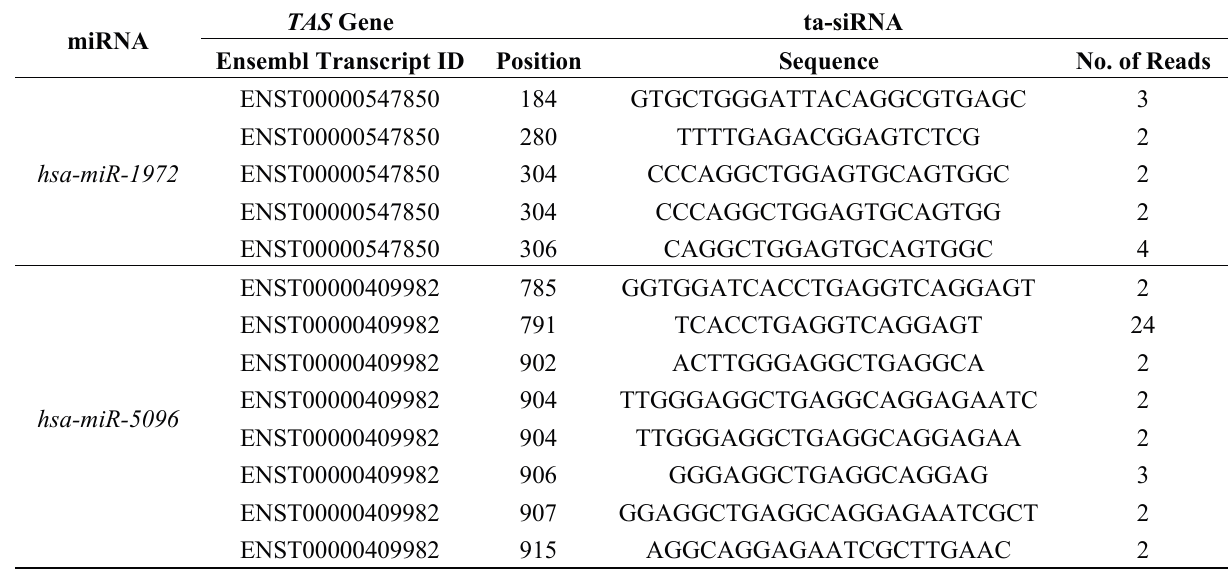
Table 2. Uncharacterized TAS genes and ta-siRNAs with specific targets in the human brain. TAS Gene ta-siRNA miRNA Ensembl Transcript ID Position Sequence No. of